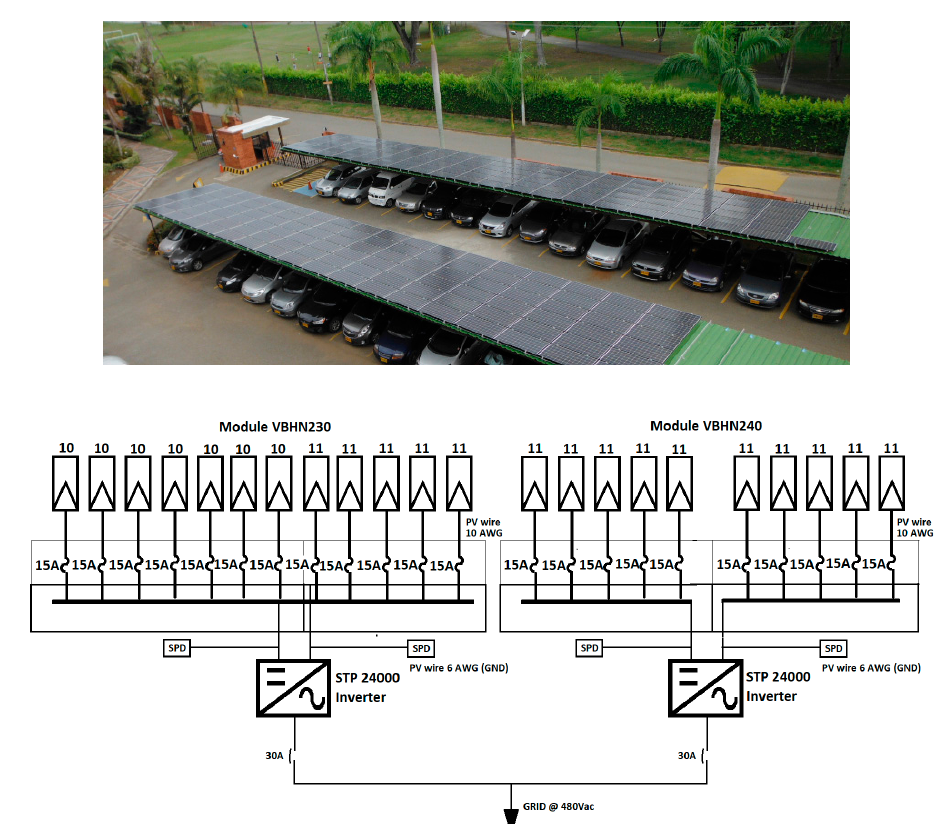
Figure 3. Parking located in the South. Stage 1.